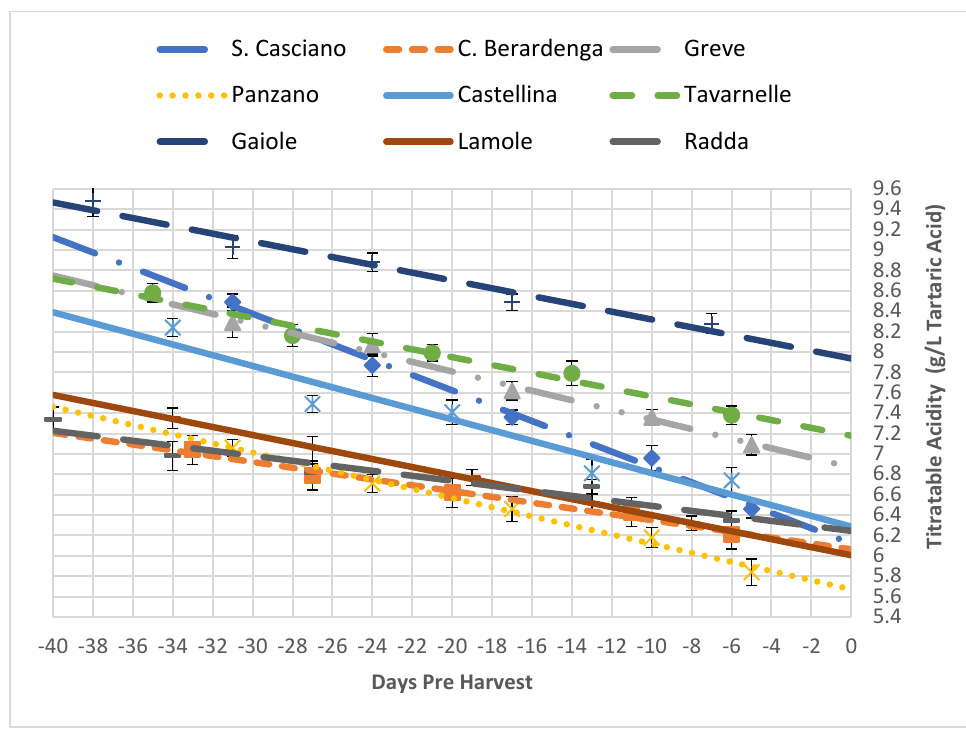
Figure 3. Trends of the titratable acidity in all the analysed vineyards as a function of time (expressed as negative days before the harvest). Each analytical point is reported with its 68% C.L. interval. Table 7. Calculated values of the functional parameters, intercept, slope and R 2 of the malic acid concentration inside the grapes coming from the different